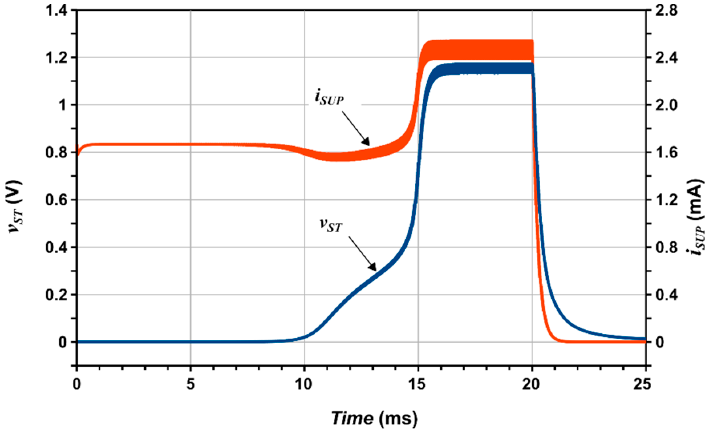
Figure 10. Waveforms of the output voltage ( v ST ) and current ( i SUP ) sourced from supply in the starter.